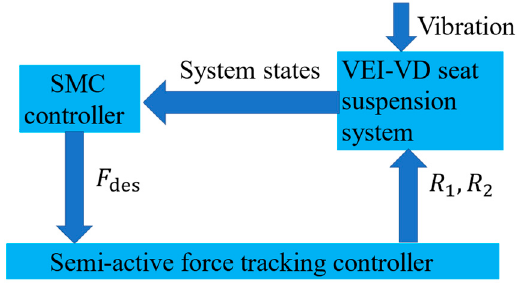
Figure 10. Control